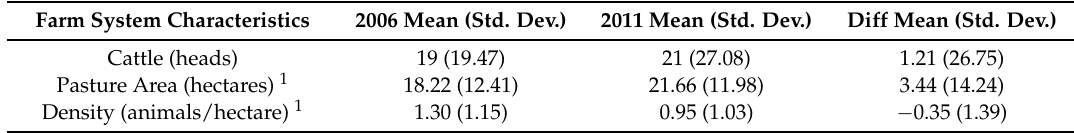
Table 3. Cattle, pasture, and stocking density: Changes between 2005 and 2010 ( N = 104).